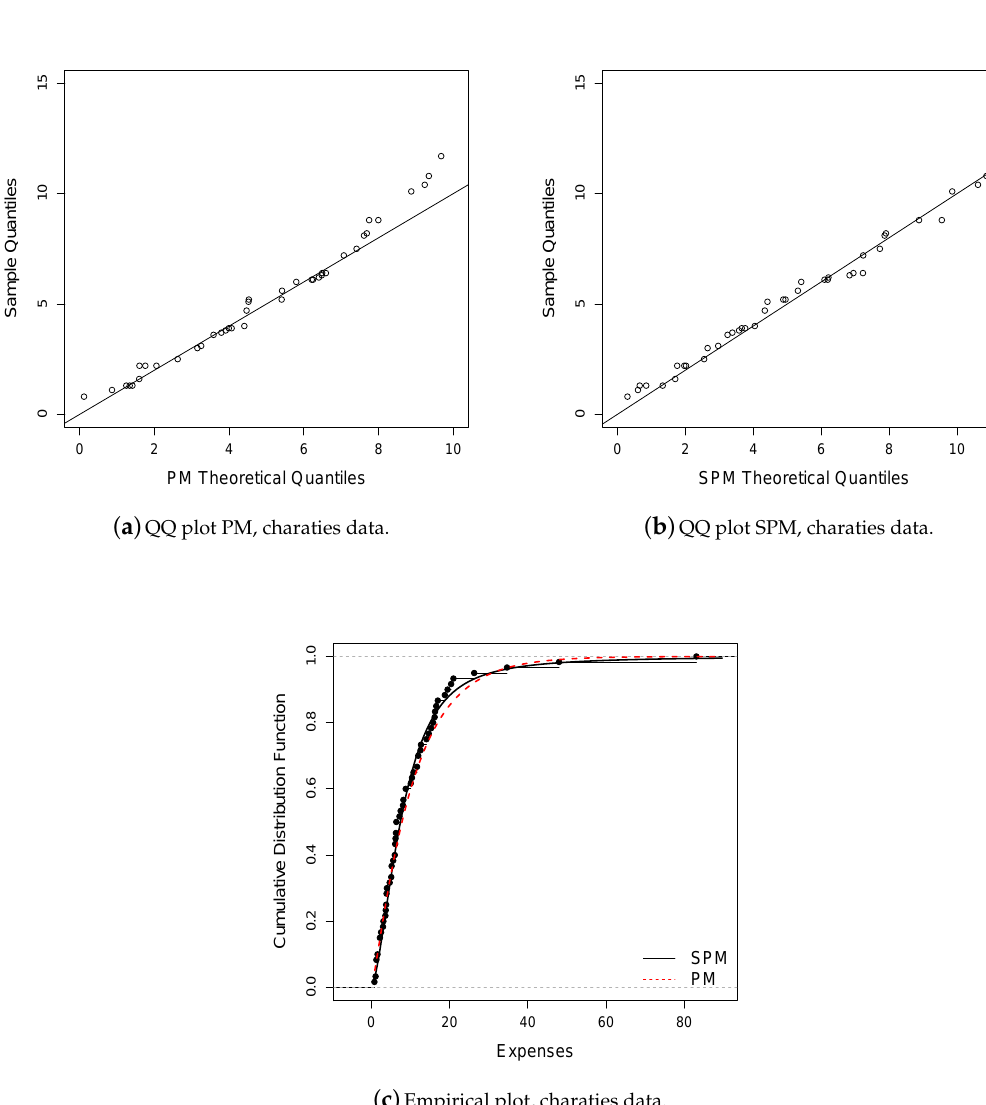
( c ) Empirical plot, charaties data. Figure 6. QQ and empirical plot, charaties